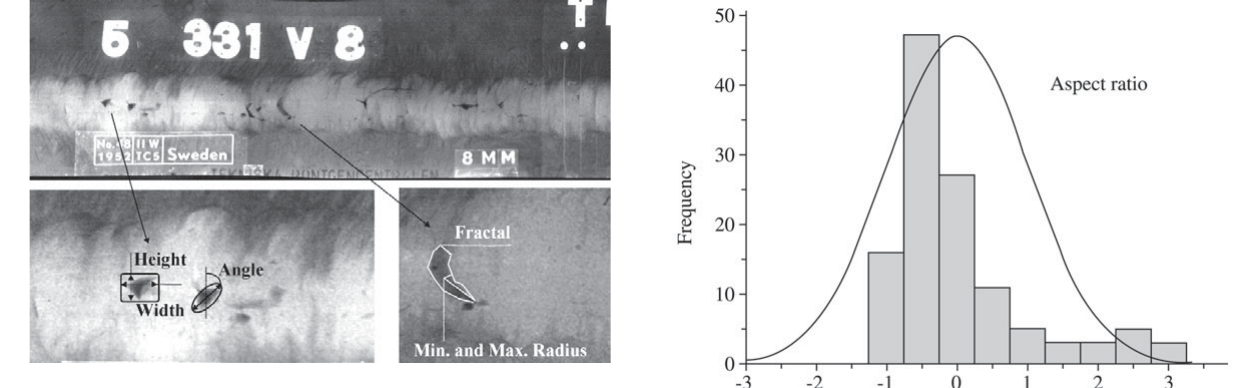
Figure 3. Example of one IIW pattern used and automatic extrac- tion of the features.